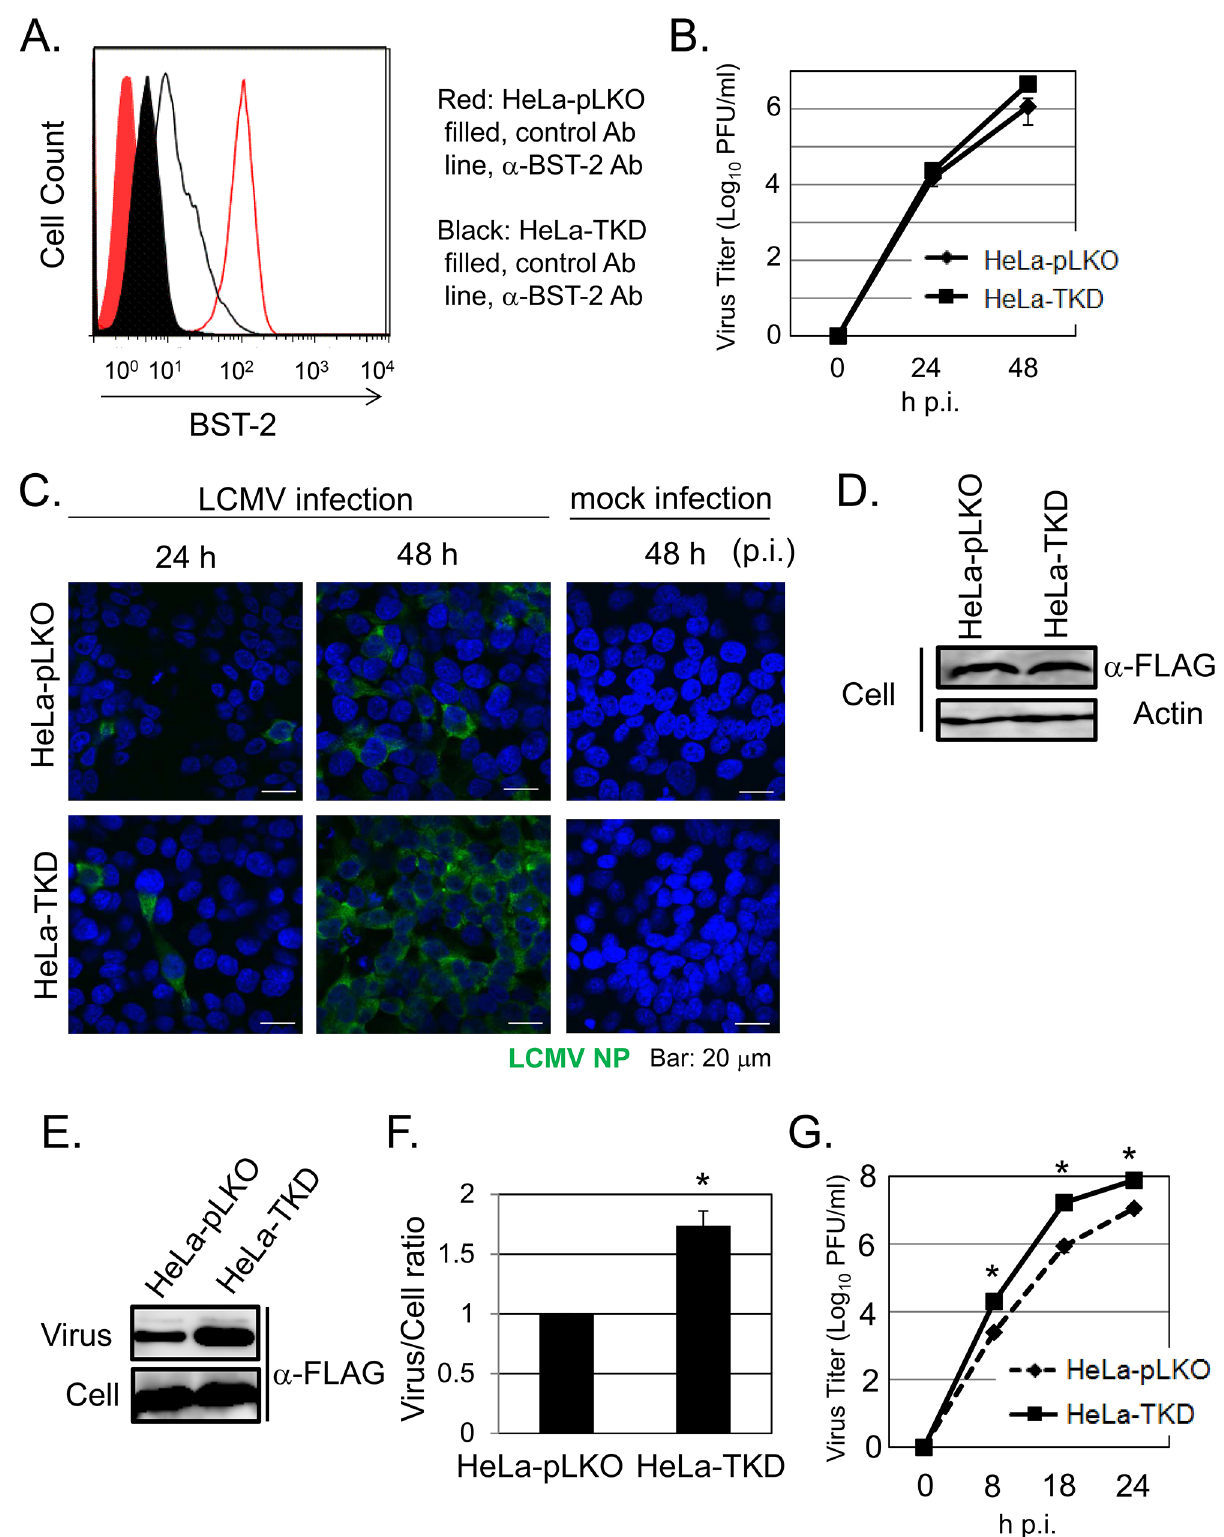
Fig 1. Endogenous BST-2 expression levels have a very limited impact on LCMV propagation in vitro .A. Cell surface expression of BST-2 in HeLa- TKD and HeLa-pLKO cells. Cells were fixed and analyzed by FACS using either a control antibody (Ab) or anti-BST-2 conjugated to PE. B. Growth